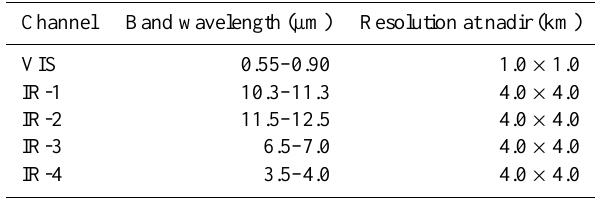
Table 1. Characteristics of MTSAT bands used in this